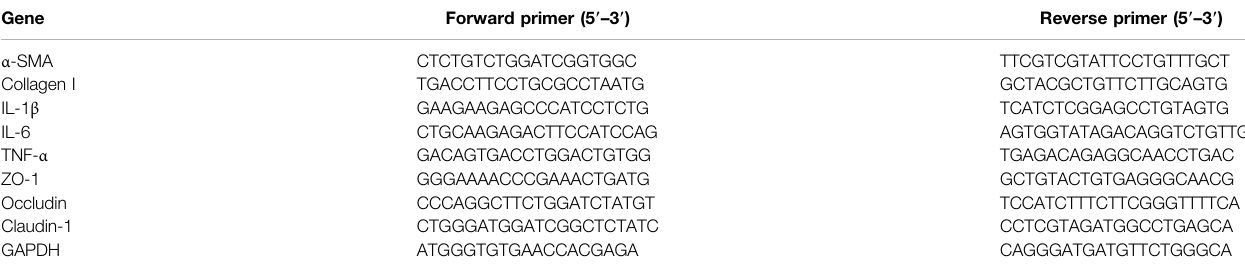
TABLE 1 | Speci fi c primers sequences used in RT-qPCR. Gene